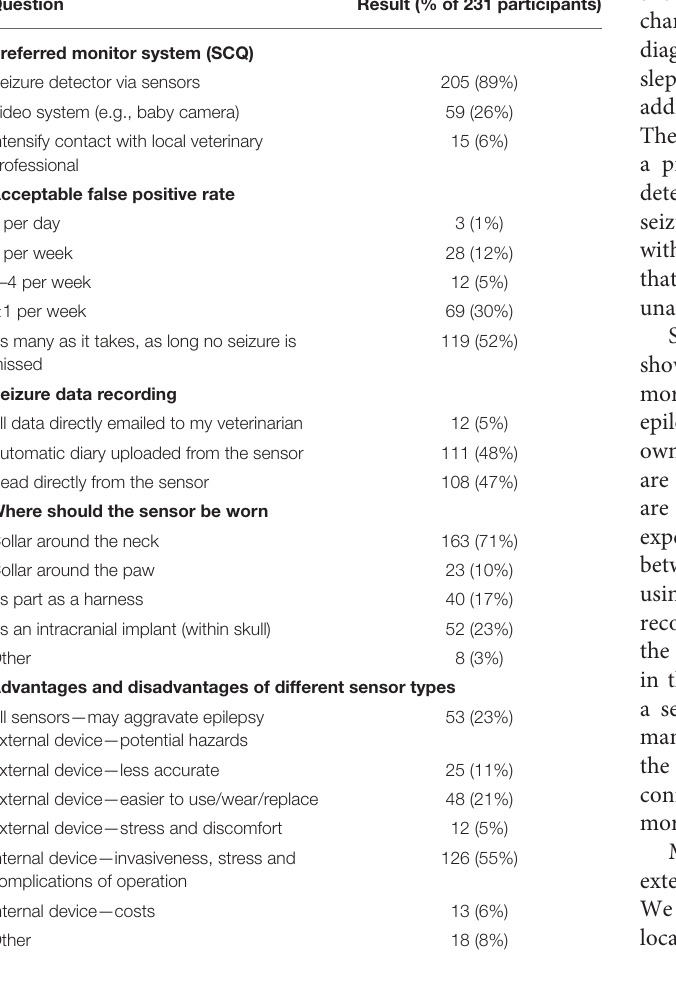
TABLE 2 | Survey results—part